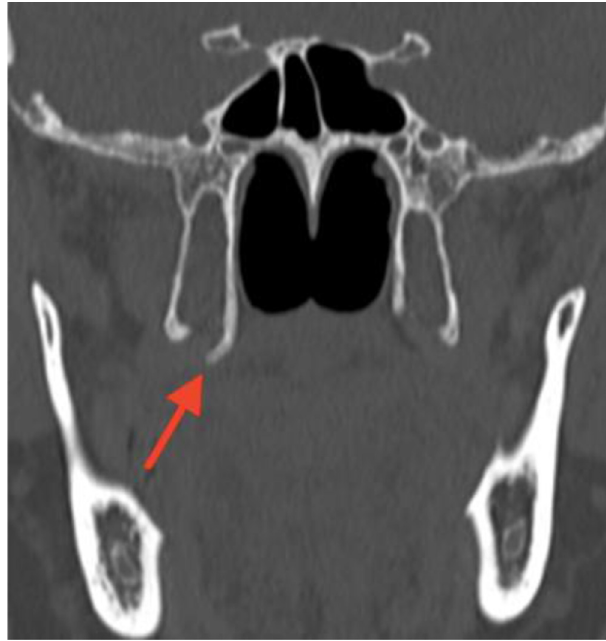
Fig. 1. Hypertrophy of the pterygoid hamulus (red arrow) on the computerized tomography (cid:1) scan (coronal section).